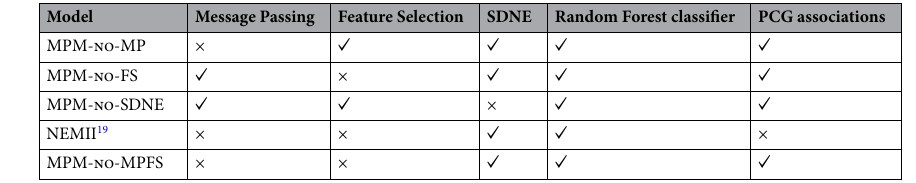
Table 5. Simpler variants of MPM where ‘ ✓ ’ and ‘×’ denote the existence and non-existence of the corresponding